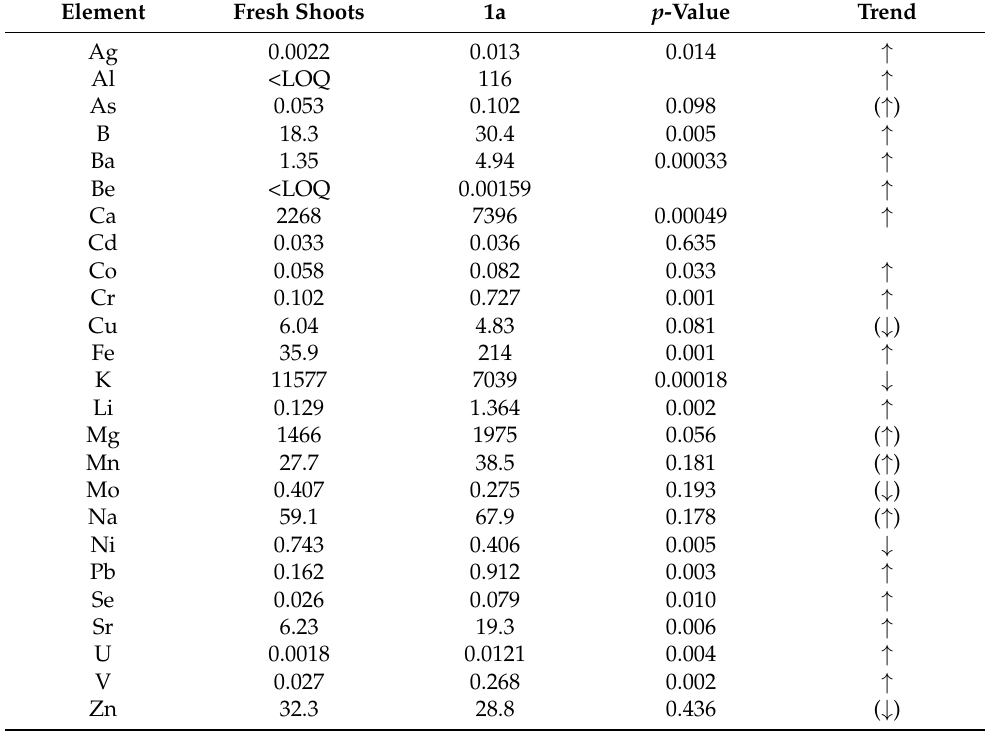
Table 3. Mean elemental contents in mg/kg (elements with statistically significant differences be- tween fresh shoots and one-year-old needles (1a) are written in italic) alongside trend ( ↑ —increas- ing; ↓ —decreasing).